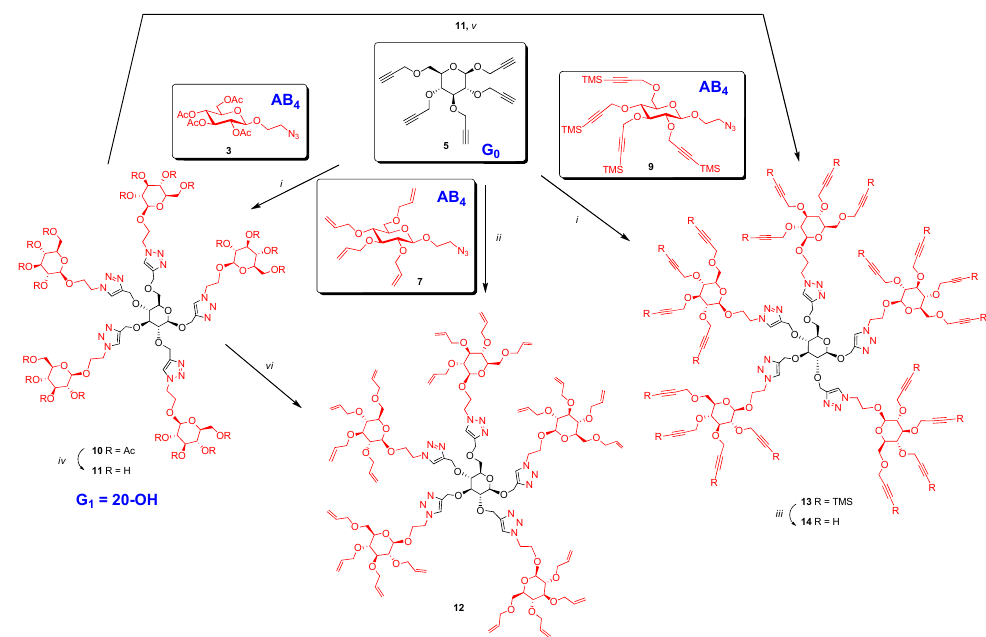
Scheme 2. Synthesis of glycodendrimer core. Reagents and conditions : (i) CuI·P(OEt) 3 , toluene, 70 °C, 20 h; 85% for 10 , 90% for 13 using Hunig’s base; (ii) CuI·P(OEt) 3 , toluene, microwave, 70 °C, 4 h, 80%;